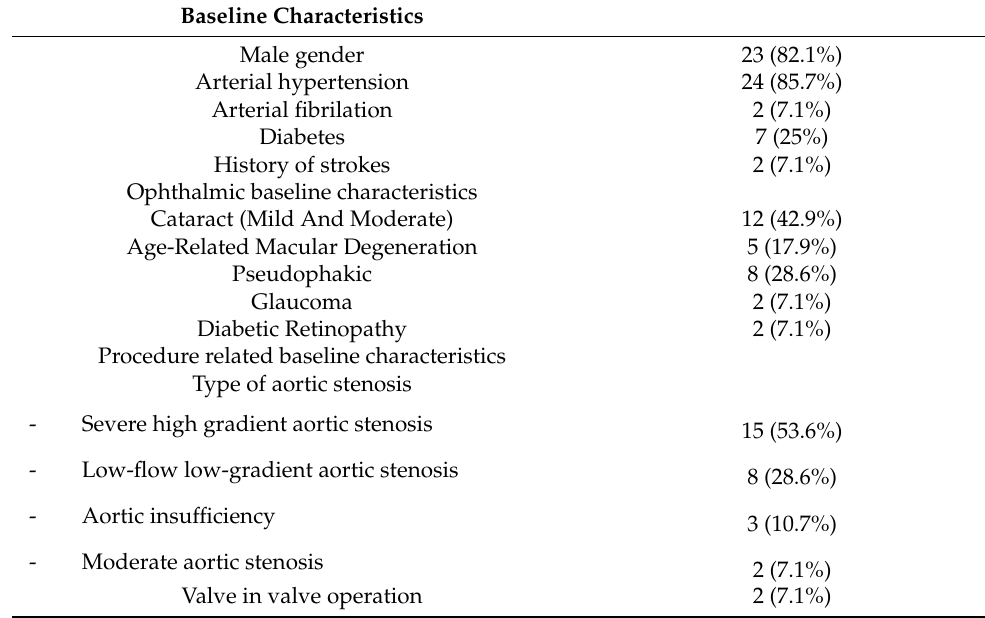
Table 1. Patient demographics. Age-related macular degeneration was mild or intermediate, no patient had clinically significant diabetic macular edema nor proliferative diabetic